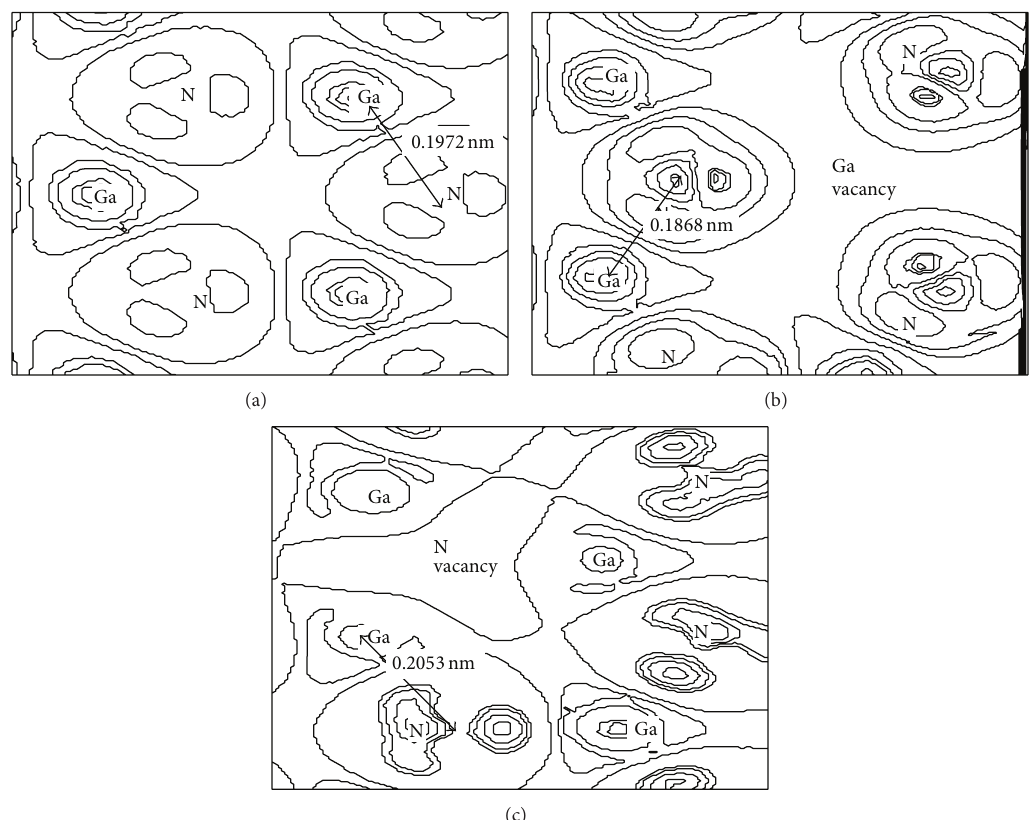
Figure 3: Electron density difference in the (0001) plane of the surface atoms: (a) intact surface, (b) Ga vacancy defect surface, and (c) N vacancy defect